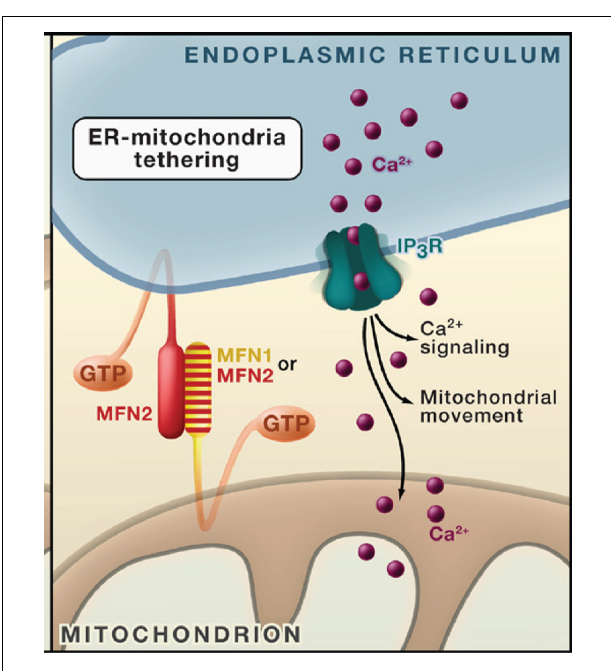
FIGURE 10 |The tethering of the ER to the mitochondria (taken from Merkwirth and Langer, 2008).